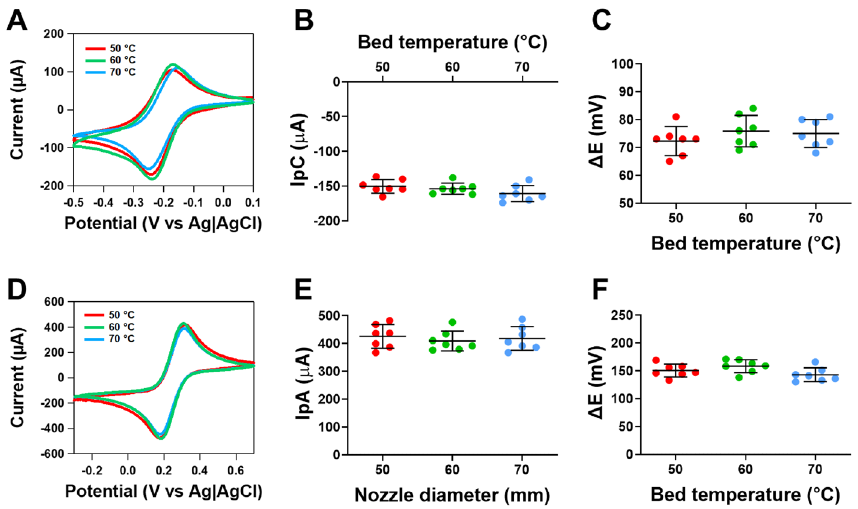
Figure 2. Responses of 3D printed CB/PLA electrodes at varying heated bed temperatures on outer and inner sphere redox probes. ( A ) Representative cyclic voltammograms of 1 mM ruthenium hexaamine in 1 M KCl at 0.05 V s −1 , ( B ) Cathodic peak current, ( C ) ΔE of ruthenium hexaamine ( D ) representative cyclic voltammograms of 5 mM ferricyanide in 1 M KCl at 0.05 V s −1 , ( E ) anodic peak current and ( F ) ΔE of ferricyanide. The extruder temperature was 230 °C and the nozzle diameter was 0.6 mm. Data shown as mean ± SD, where n =